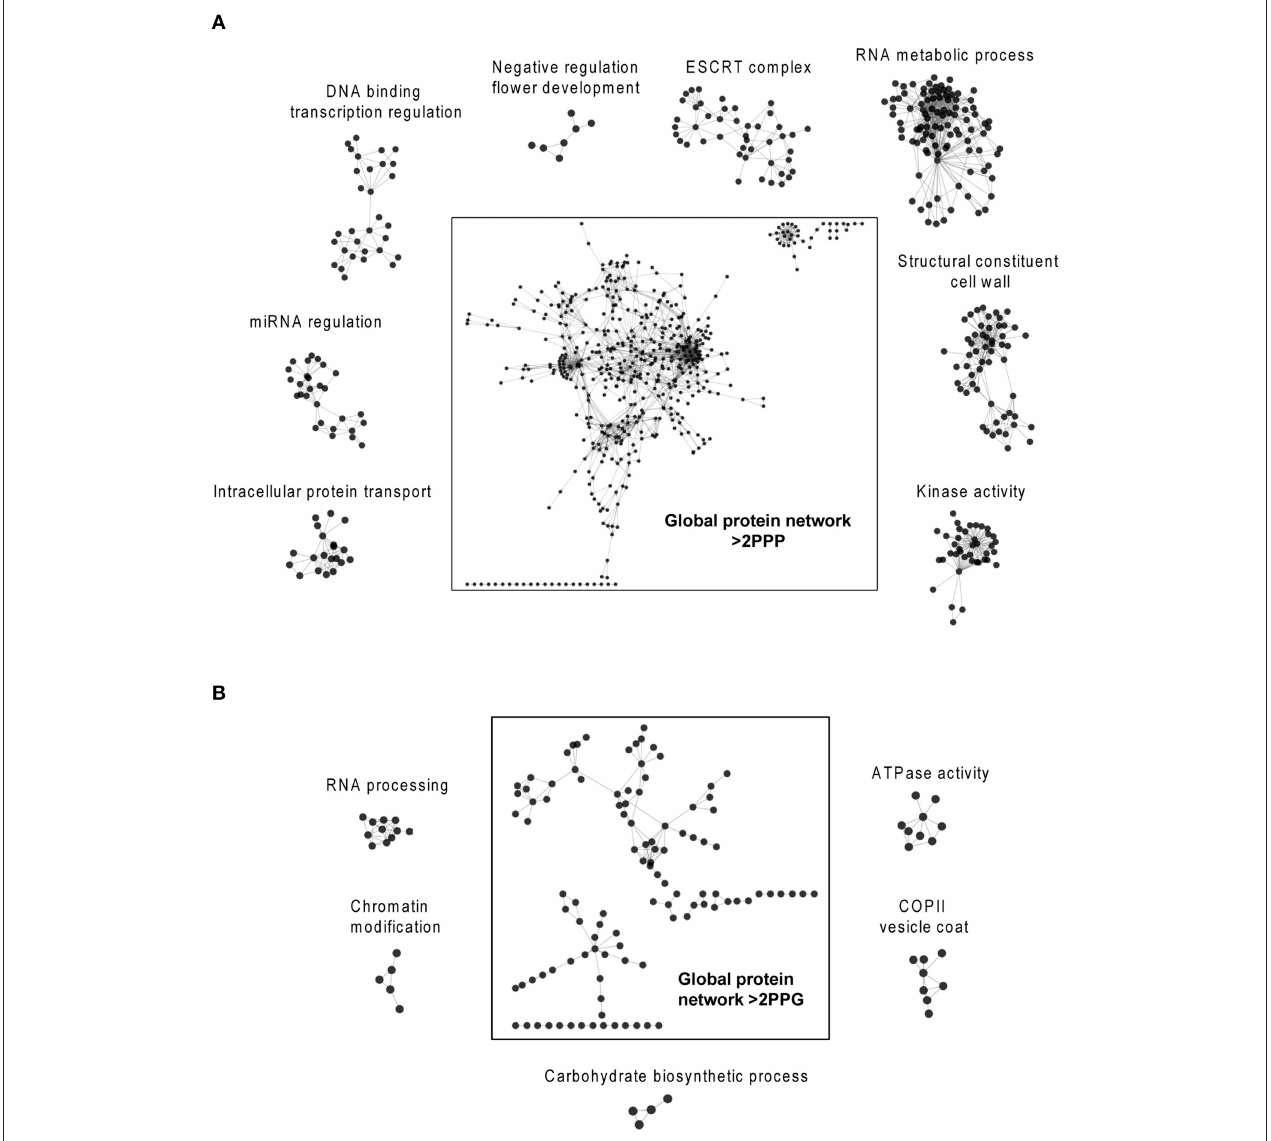
FIGURE 7 | Bioinformatic search of polyproline-rich protein network clusters. The Arabidopsis lists of proteins with > 2 PPP units (A) or > 2 PPG units (B) were analyzed with the String web-based tool and visualized with the program Cytoscape. The Cytoscape plugins MCODE and BiNGO were used to identify protein clusters and to determine their gene ontology, respectively. The highest scoring clusters are represented surrounding the global networks. Additional information on the global gene ontology data for both protein networks are shown in Tables S1,